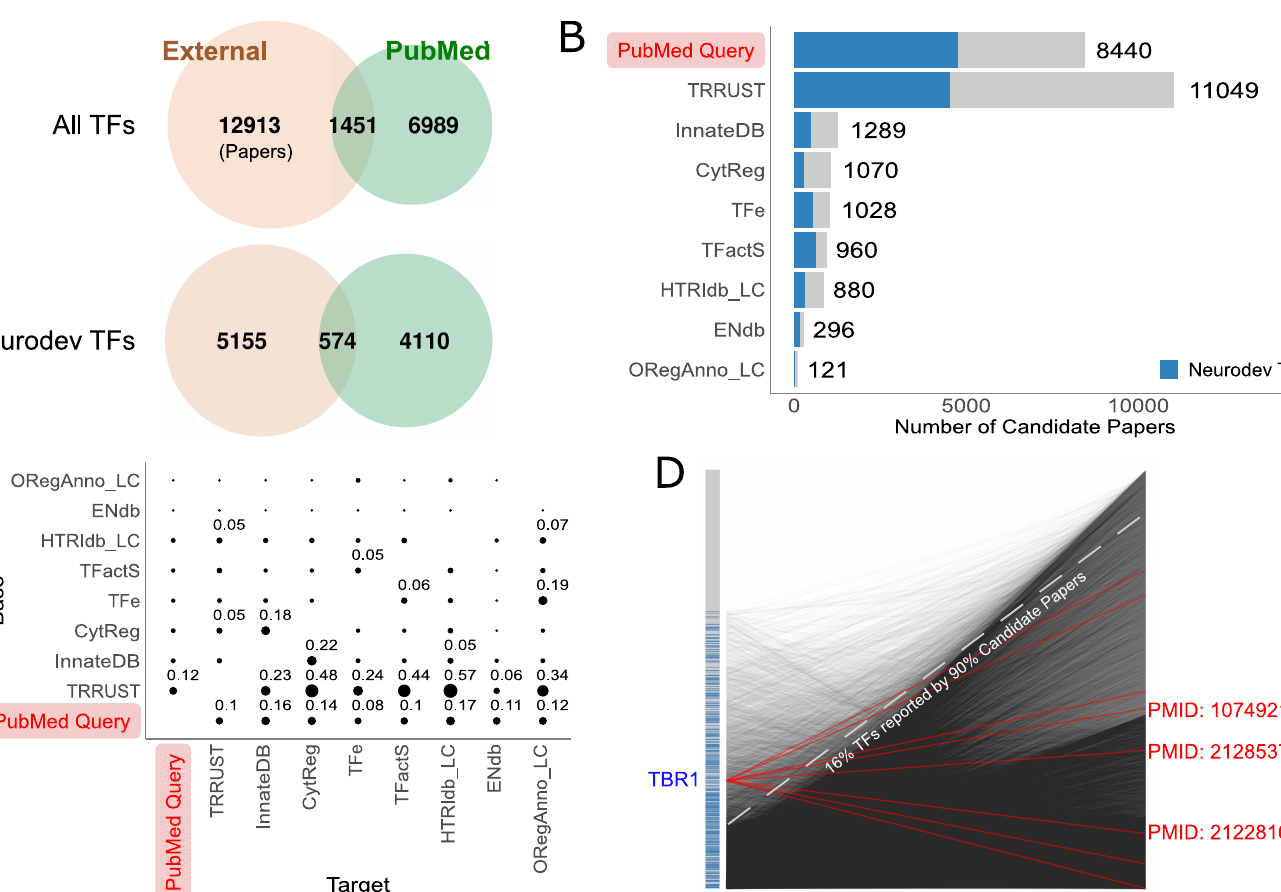
Fig 2. Overview of the candidate literature corpus. (A) Venn diagrams showing the overlap between candidate papers sourced from external data resources versus our independent PubMed query, broken down by all TFs (top) and those associated with neurodevelopmental TFs (bottom) (B) Number of candidate papers retrieved from each data resource. Papers associated with neurodevelopmental TFs are highlighted in blue. (C) Pairwise overlap of candidate papers among the different sources shown as fractions of the “target” source (horizontal axis). For example, TRRUST contains 0.48 of the papers recorded in CytReg whereas CytReg contains only 0.05 of the papers in TRRUST. Only values of 0.05 or higher are displayed. External resources are ordered by the number of recorded publications. (D) Summary of associations between TFs and candidate papers. Each point on the left vertical axis is a TF, ordered by the number of candidate papers assigned (TFs with the highest number of candidate papers are at the bottom). Neurodevelopmental TFs are highlighted in blue. Each point on the right vertical axis is a candidate paper, ordered by the number of associated TF (papers with the highest number of candidate papers are at the bottom). Each line denotes a TF-paper association. For example, TBR1 (highlighted) is associated with eight candidate papers (red lines), the PubMed IDs of three papers are printed as